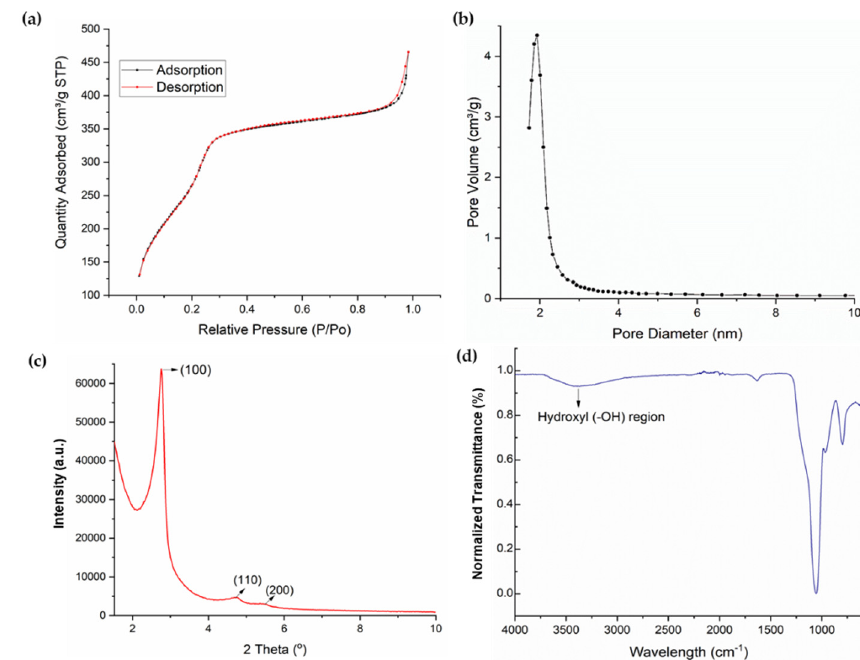
Figure 1. Physiochemical properties of native MSNs: ( a ) Type IV N 2 adsorption-desorption isotherm of resulting particles, a distinct feature of mesoporous materials [39]. ( b ) Particles have an average pore diameter of 2.4 nm, which fits the definition of MSNs having pore diameters ranging from 2 to 50 nm [11,12]. ( c ) MSNs demonstrated three distinct diffraction peaks, assigned as (100), (110) and (200) planes, a characteristic crystalized lattice of MCM-41 [36,40]. ( d ) FT-IR spectra of native MSNs demonstrating the ( − OH) signal [41] which is essential for further surface